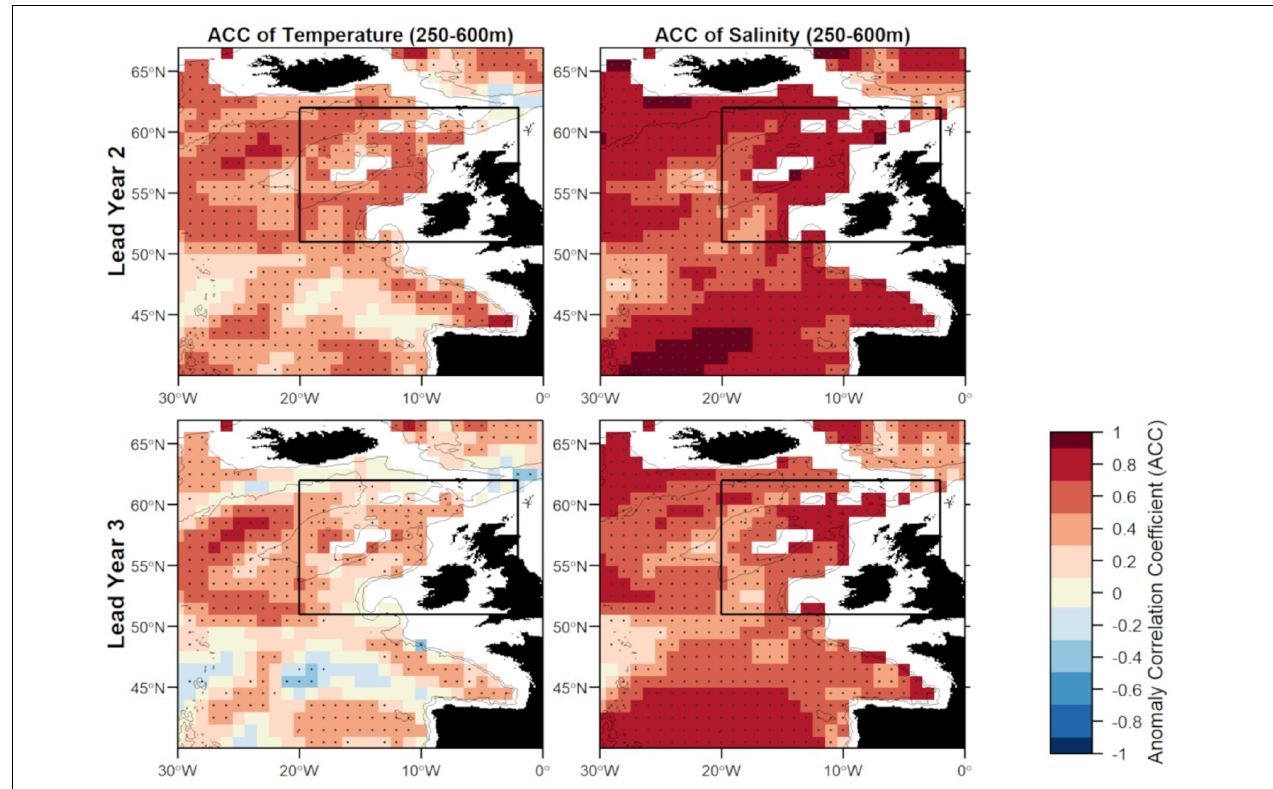
FIGURE 6 | Anomaly correlation coefficient (ACC) of temperature (left) and salinity (right) in FMA at lead year 2 ( ≈ 16 months) (top) and lead year 3 ( ≈ 28 months) (bottom) comparing MPI-ESM-hindcast to MPI-ESM-assim . Dots show significant correlations at the 95% confidence level, calculated from 500 bootstrap samples. The black rectangle delineates the study area: the spawning region of blue whiting; and black lines indicate the 600 and 2,000 m isobath.